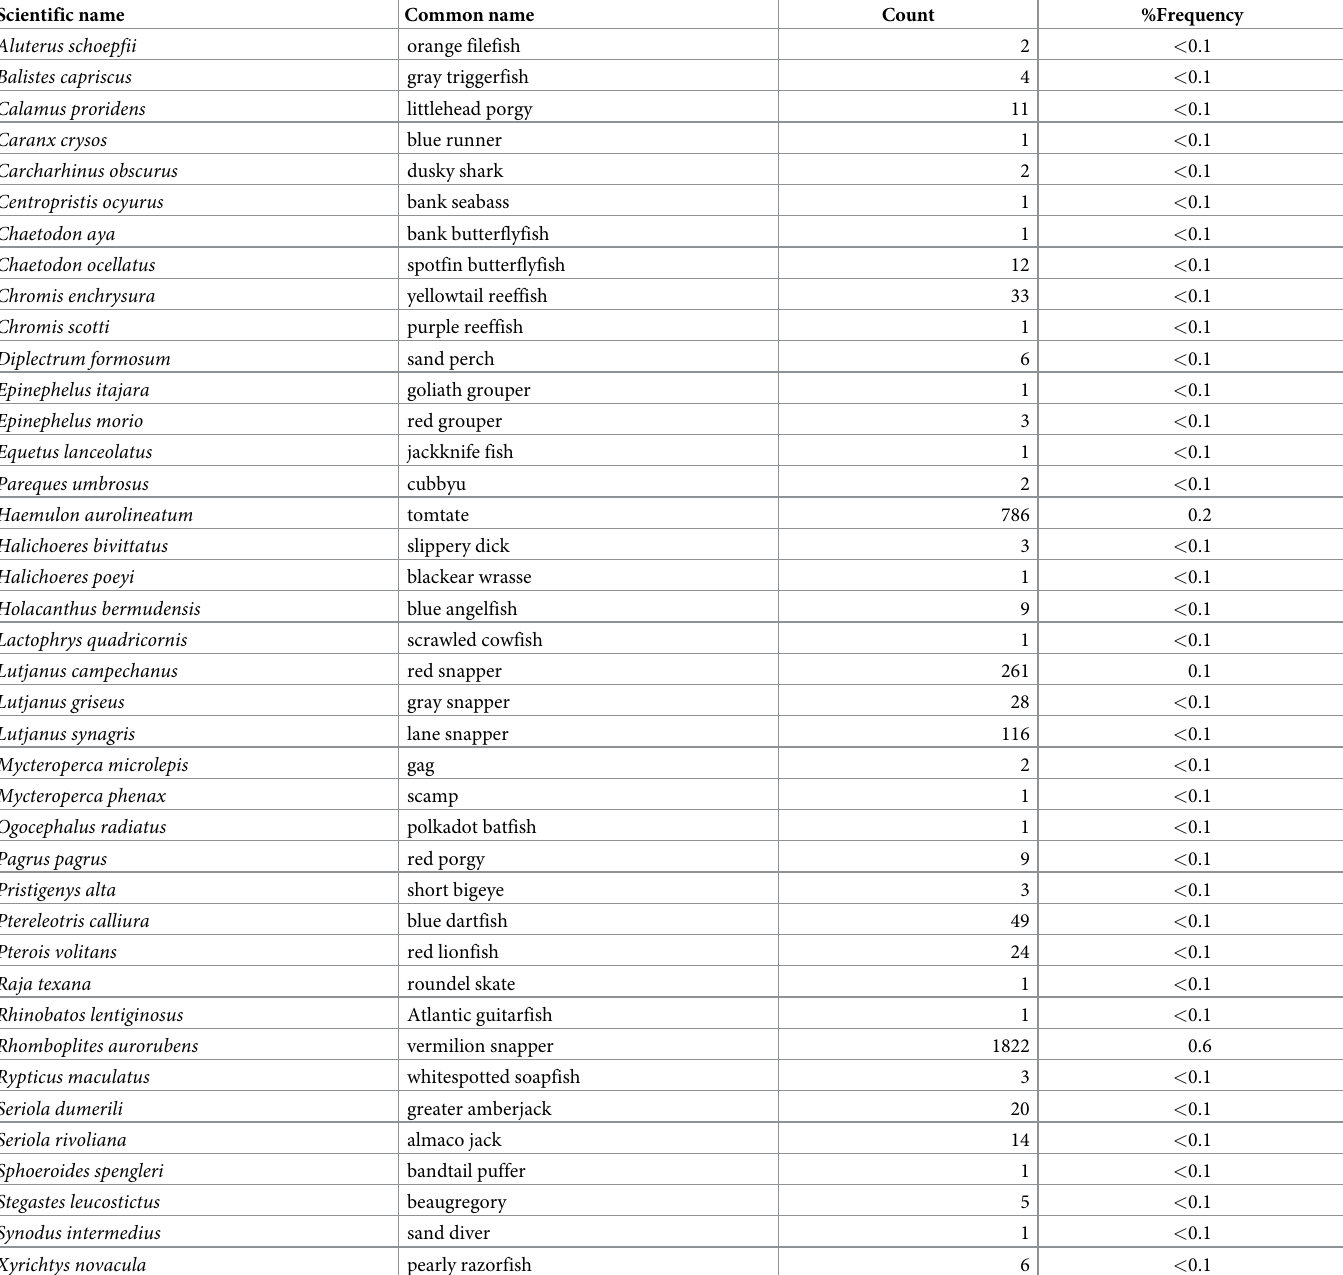
Table 1. List of observed species and their